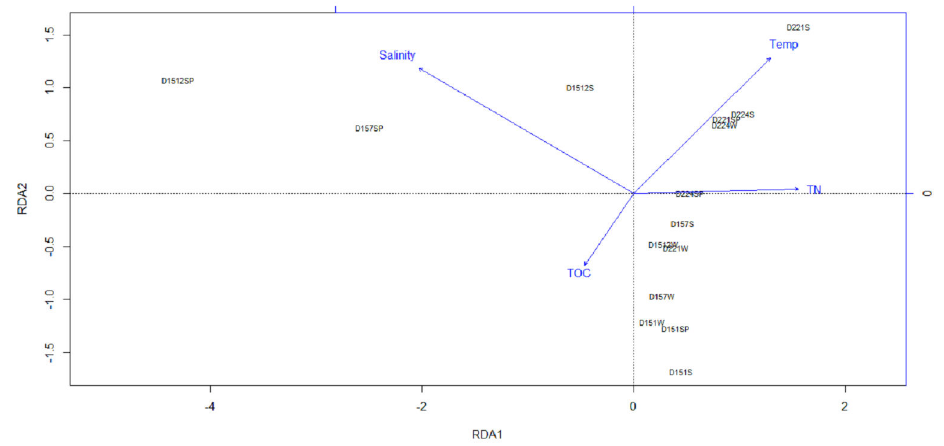
Figure 6. RDA ordination plots for the environmental parameters and the bacterial communities represented by 16S rRNA gene